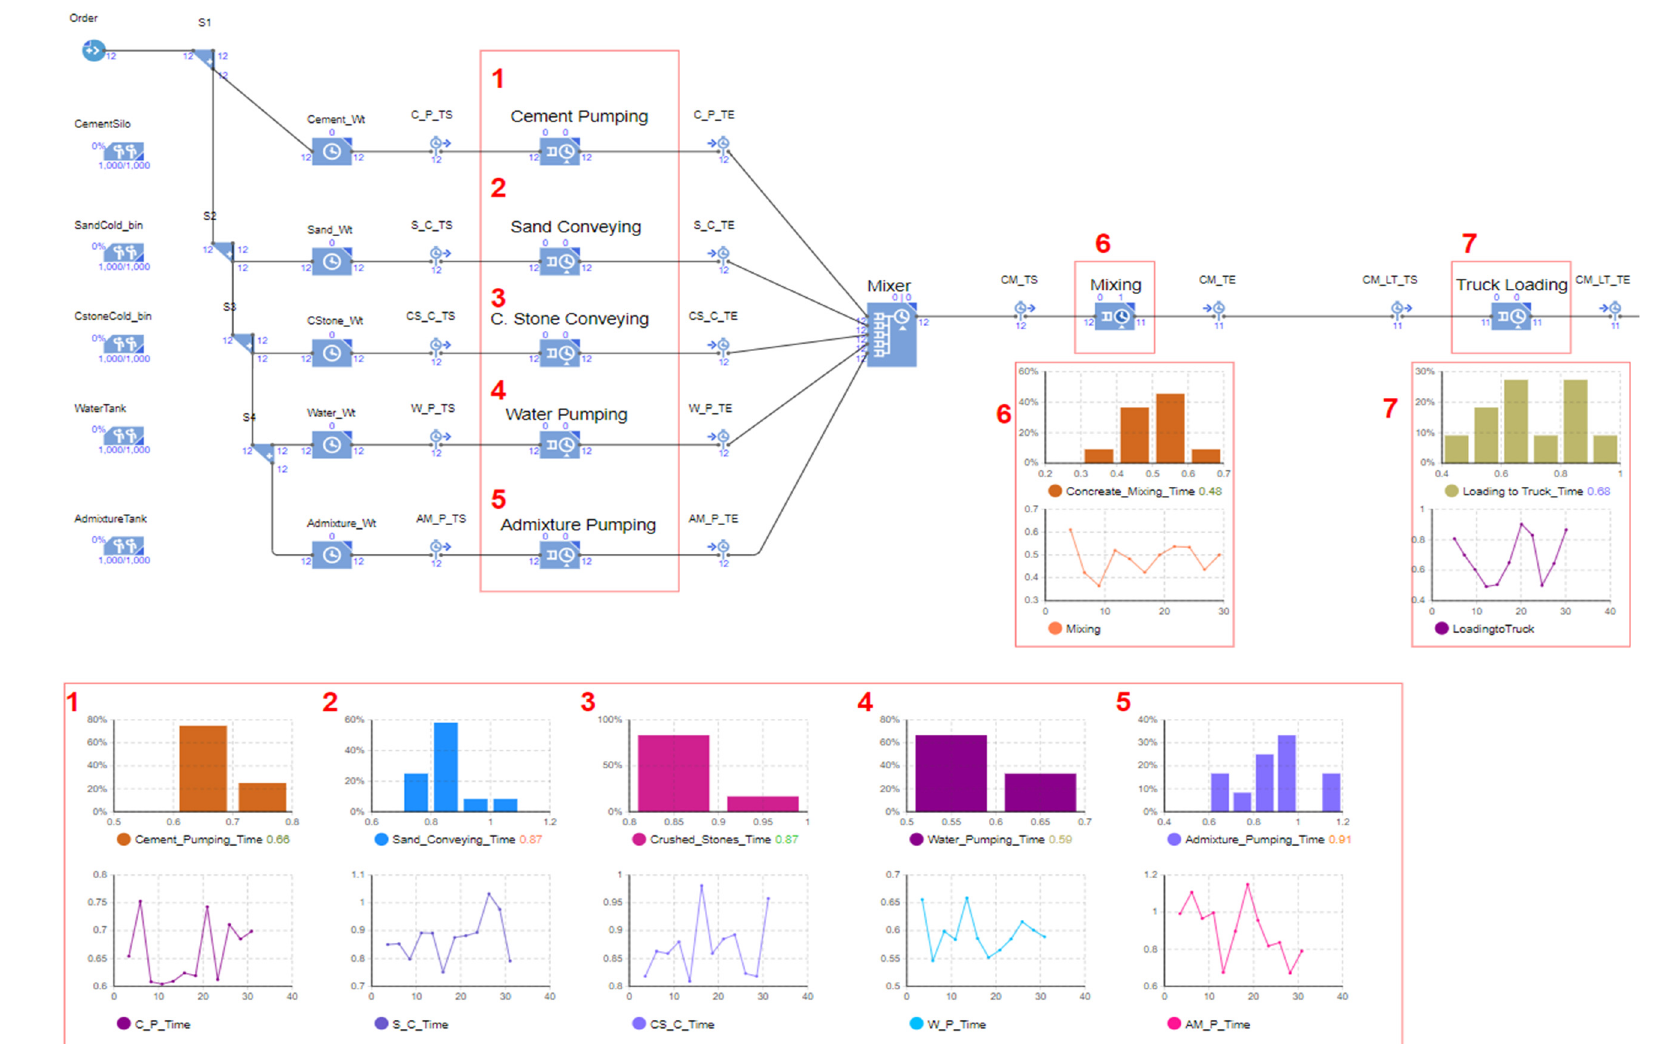
Figure 15. Digital Twin Operational Model.